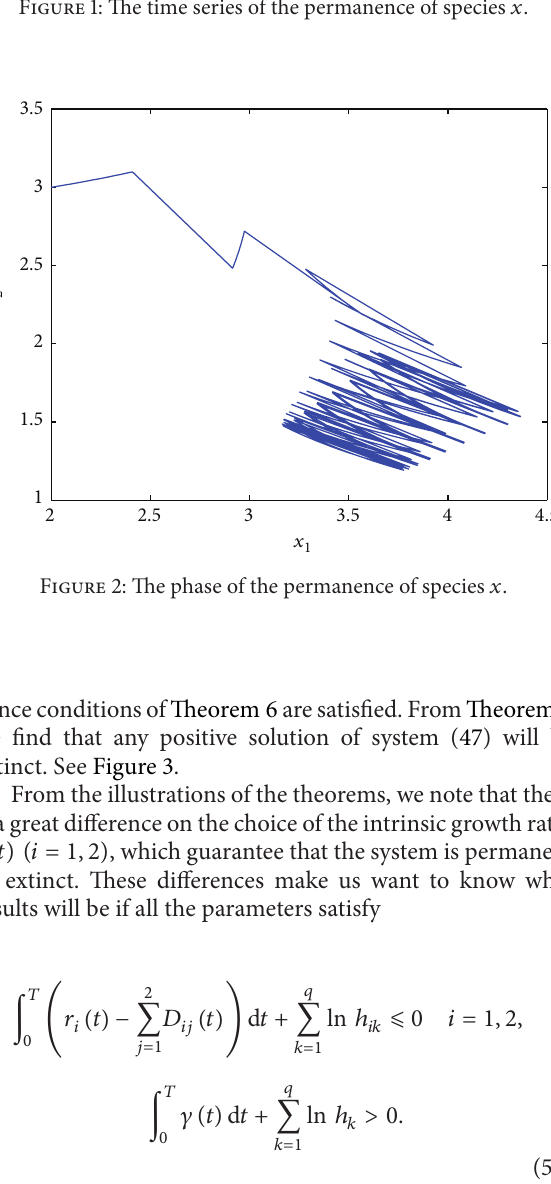
Figure 1: The time series of the permanence of species 𝑥 .